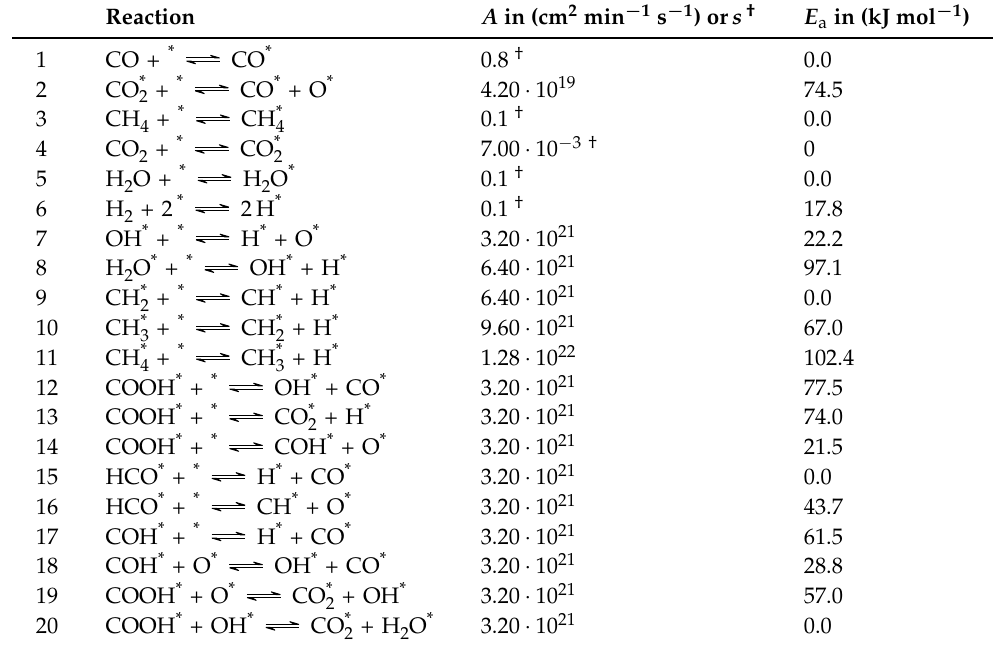
Table 1. Microkinetic mechanism of the CO 2 methanation from ref. [53]. † indicate initial sticking